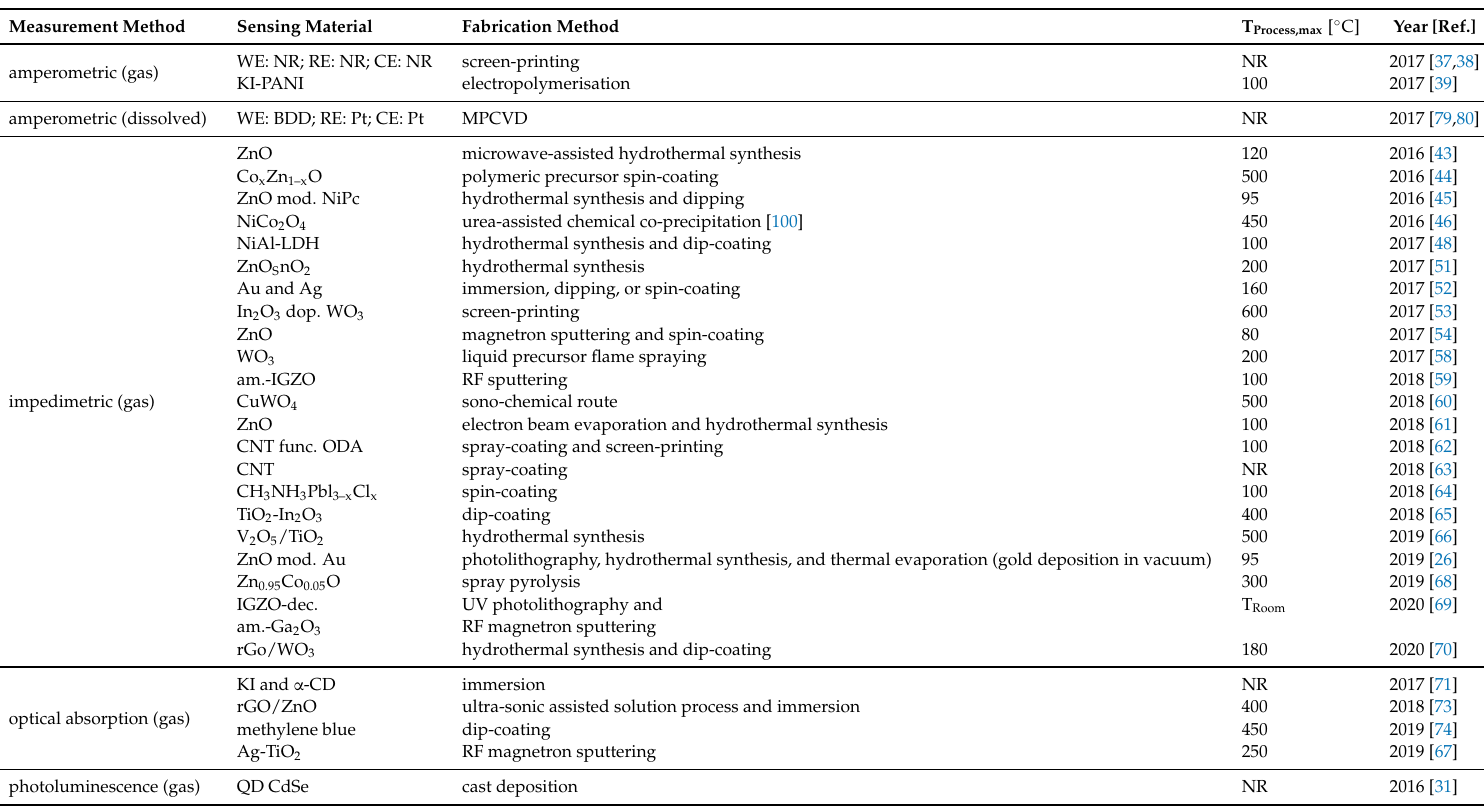
Table 5. Overview of fabrication methods for ozone sensors. Information about the measurement method, sensing material, fabrication method, and maximum process temperature is